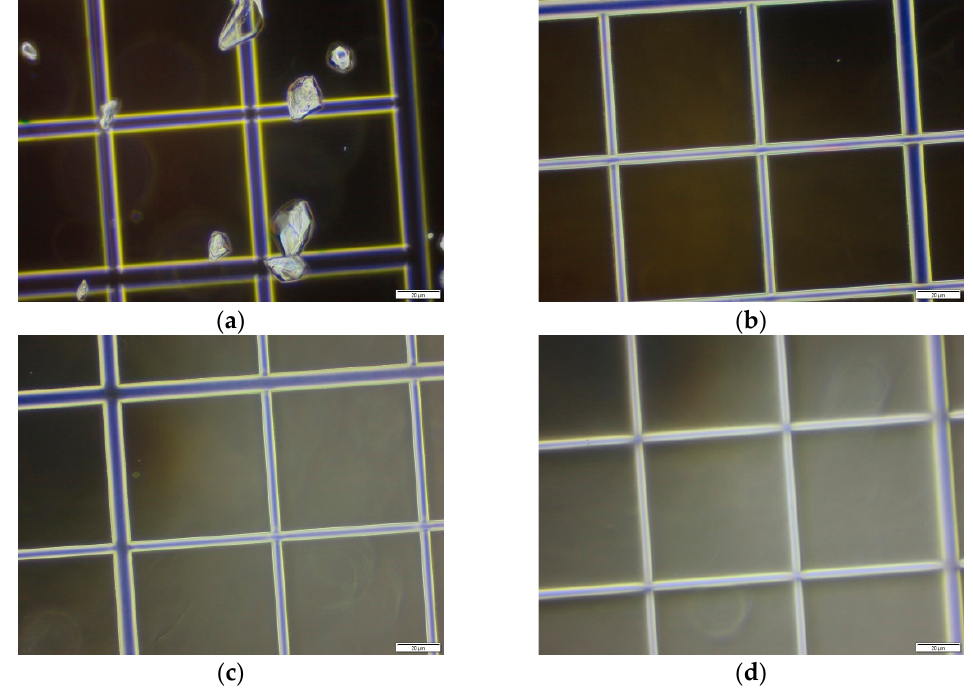
Figure 2. Observation under light microscope of ( a ) suspension of paracetamol (Doliprane ® 2.4%); ( b ) water; ( c ) matrix without nicardipine hydrochloride 2 mg/mL; ( d ) nicardipine hydrochloride 2 mg/mL formulation. Scale bar = 20 μ m.